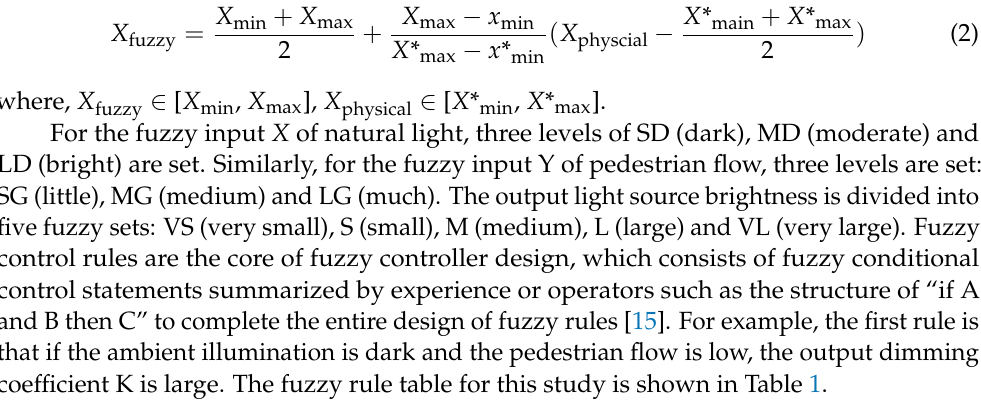
Table 1. Fuzzy rule